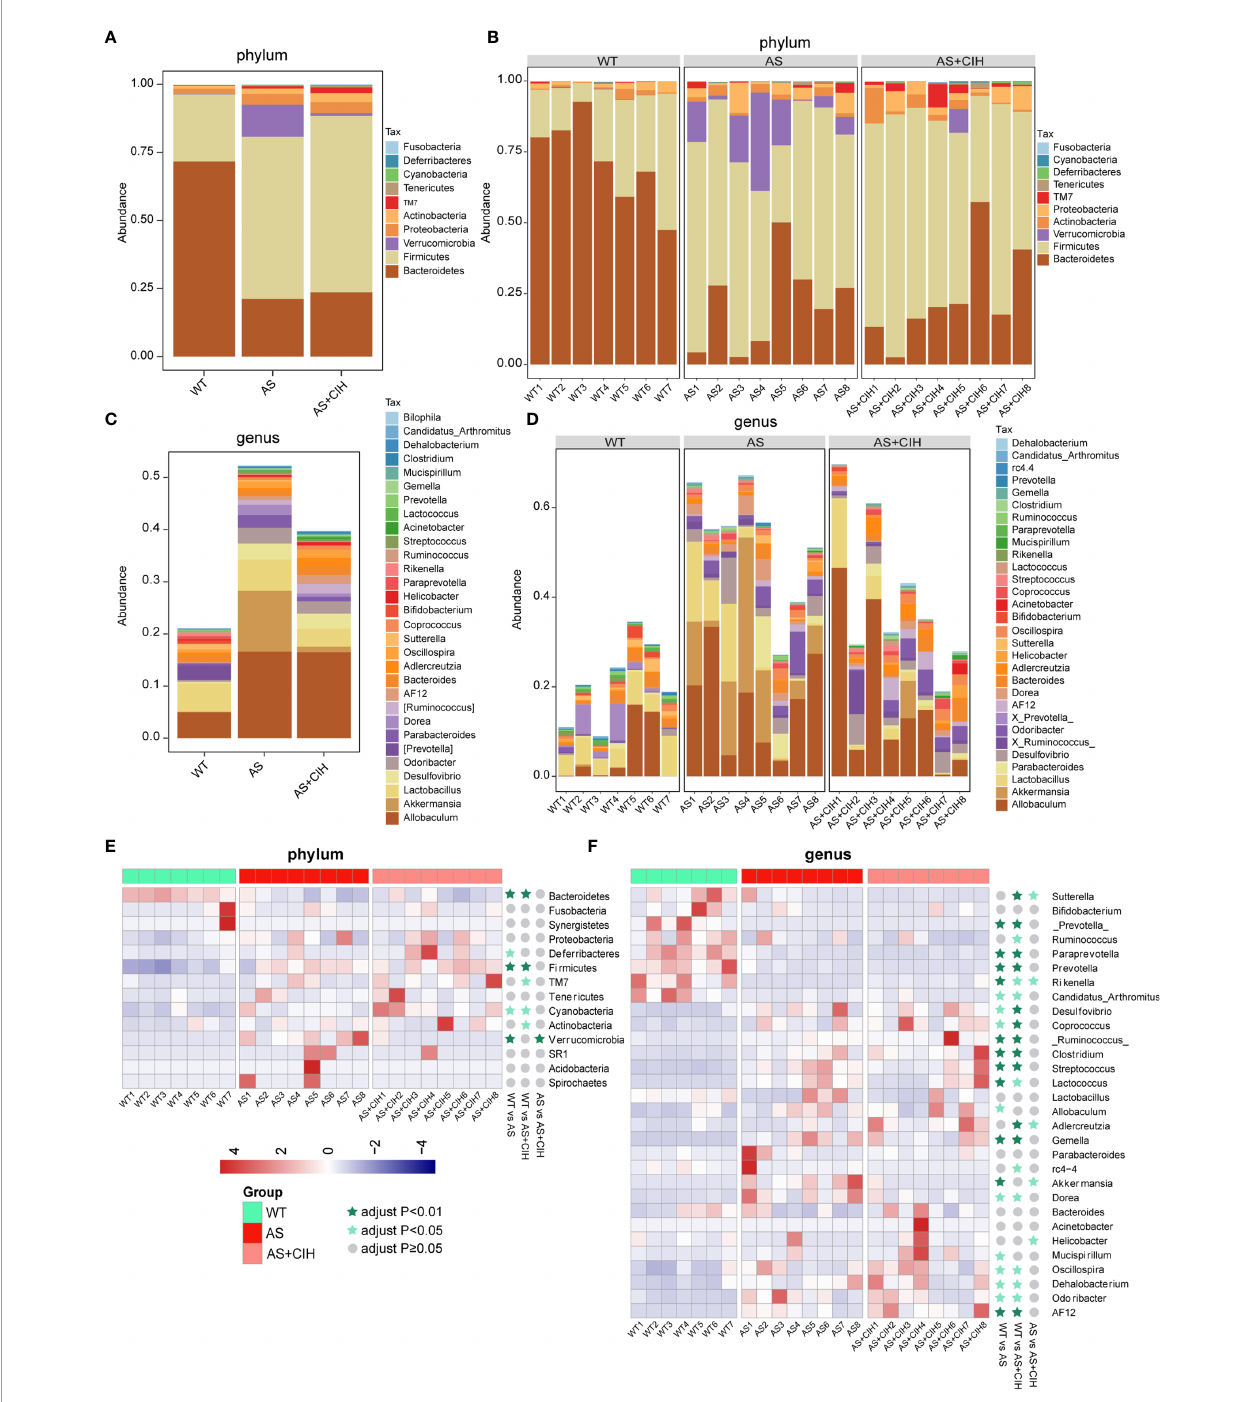
FIGURE 3 | Gut taxonomic pro fi ling of bacterial communities following CIH induction. (A – C) The bar plots indicate the mean relative abundance of top 10 phyla (A) and the top 30 genera (C) annotated in WT, AS and AS+CIH groups, where phyla and genera are differentiated by color. (B, D) Bar plots of the relative abundance of the top 10 phyla (B) and top 30 genera (D) annotated in each sample from WT, AS and AS+CIH. Phyla and genera are differentiated by color. (E, F) Heat map showing the top 14 (E) and top 30 (F) dominant bacteria annotated at the phyla and genus level respectively. The relative abundances are expressed by Z scores by subtracting the average abundance and dividing the standard deviation of all samples. Z scores are represented by blue color when the row abundance is lower than the mean and with red when the row abundance is higher than the mean. The taxon at P value <0.01 is marked with dark green star, whereas when the P value <0.05 the taxon is marked with light green star, and when the P value ≥ 0.05 with gray circle. n=7 for WT, and n=8 for AS and